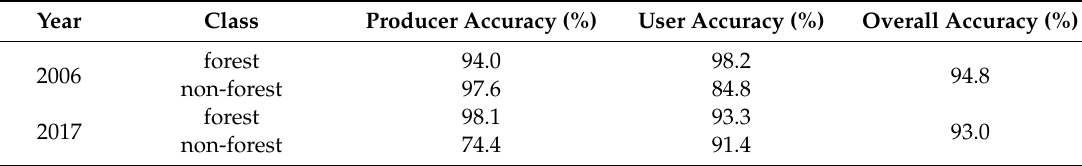
Table 6. Accuracy assessment of the forest cover maps of 2006 and